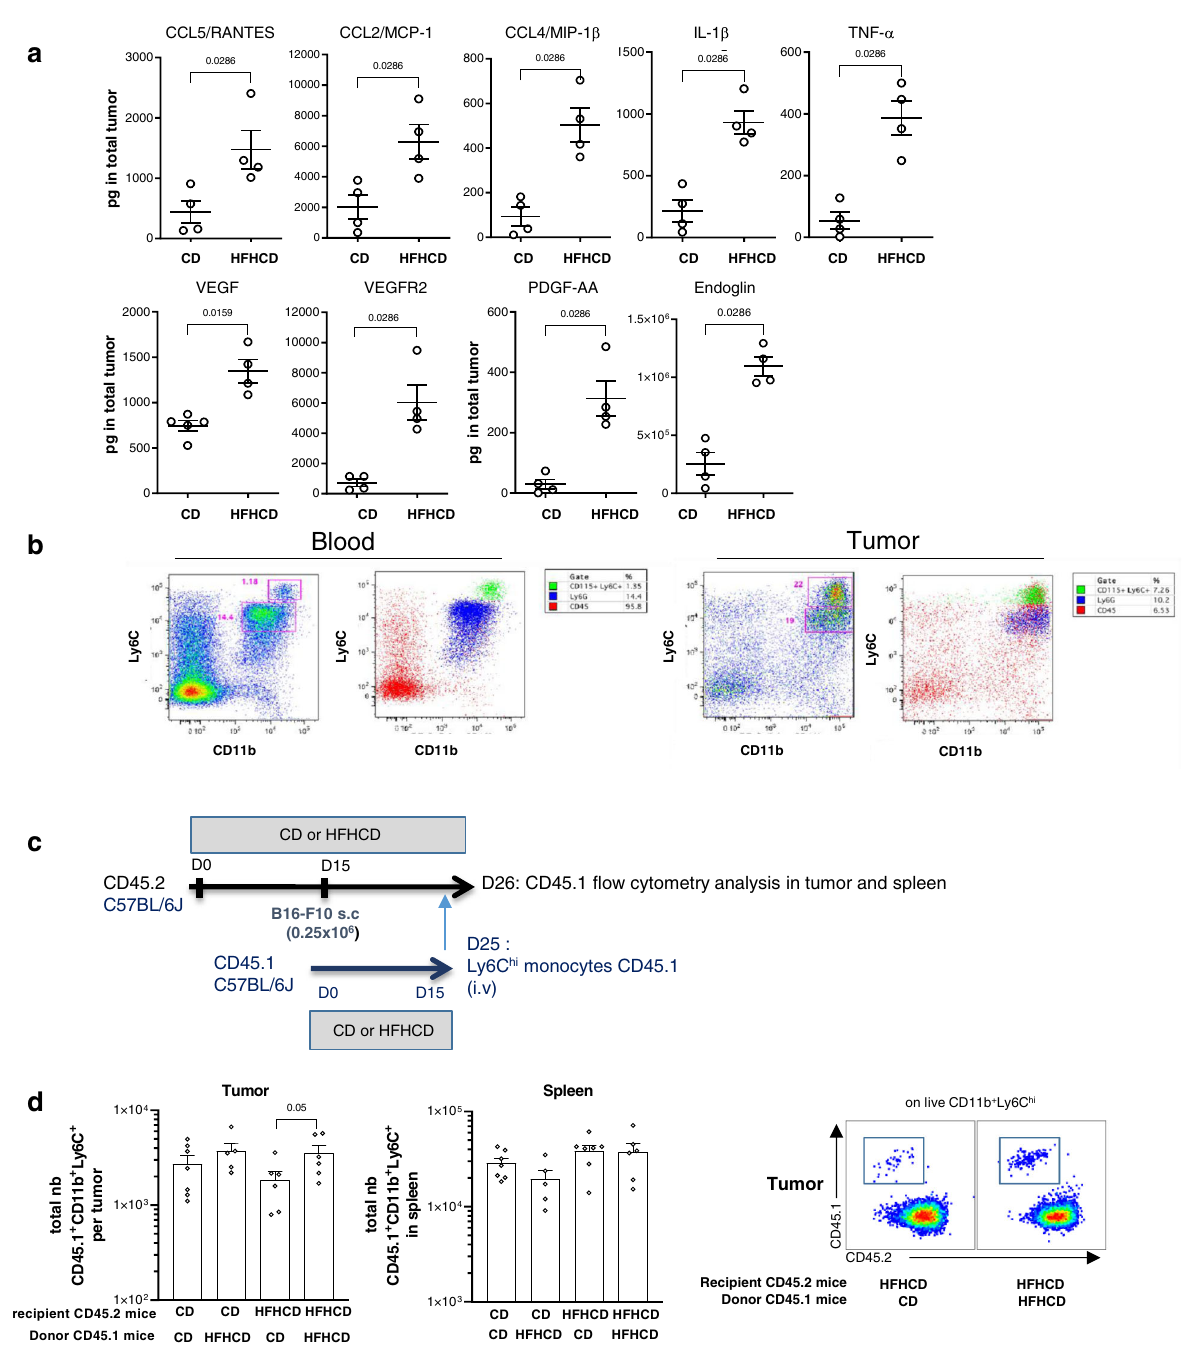
Fig. 3 | HFHCD favors migrationofmyeloid cells into the tumor. C57BL/6J mice werefedfor2weekswithchowdiet(CD)orhighfathighcholesteroldiet(HFHCD), then grafted with B16-F10 melanoma cells. a Cytokines and chemokines were measured by bead-based multiplex immunoassay ( n =4 mice/group) or Elisa ( n =5 in CD group and n =4 in HFHCD group) in total B16-F10 tumor in CD or HFHCD miceatday15aftertumorgraft. b Invivolabelingof monocytesandneutrophilsat day 8 after tumor graft: anti-Ly6G and anti-CD115 antibody were injected i.v. Six hours after injection, labeled cells were identi fi ed in blood and tumors by fl ow cytometry. Representive dot plots were showed. c , d Adoptive transfer of Ly6C hi